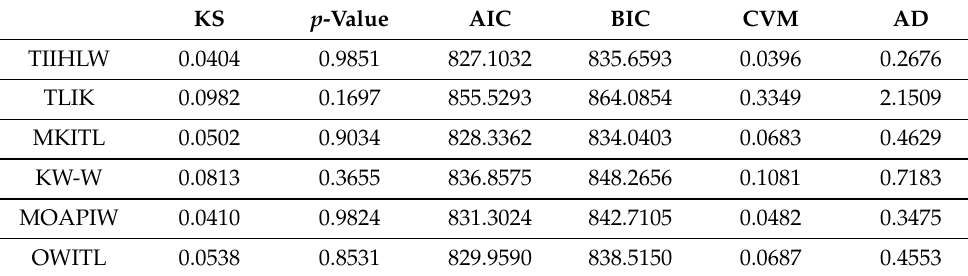
Table 7. AIC, CAIC, KS test, CVM, and AD.